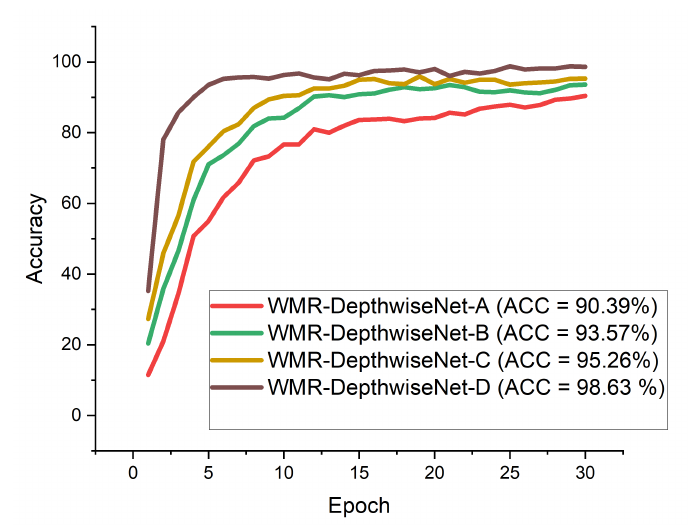
Figure 8. Accuracy curves showing the performance of our proposed WMR-DepthwiseNet in comparison with some selected up-to-date COVID-19 models using the same CXR dataset.